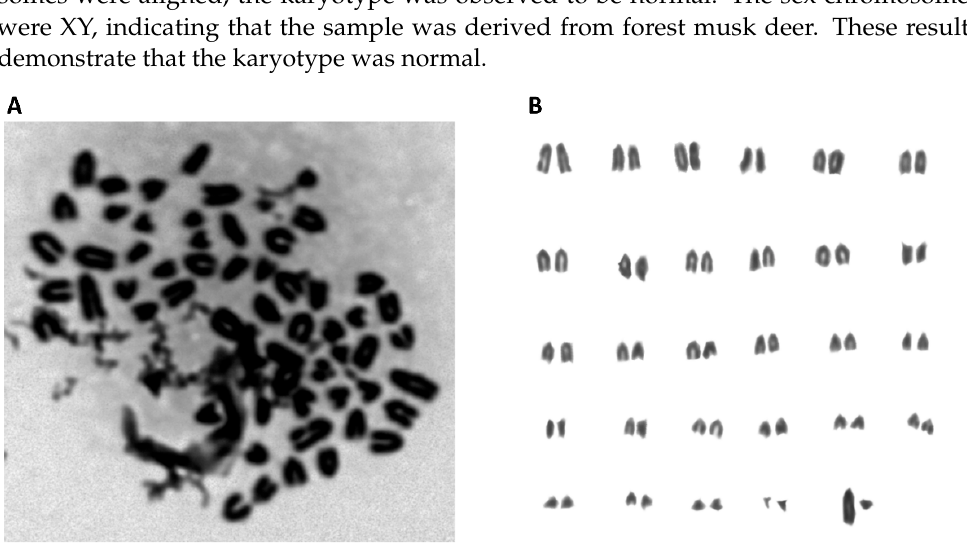
Figure 1. ( A ) Cell morphology of MSCs in vitro cultured at 3 passages. Cells exhibited spindle and fusiform shapes. Scale bar: 100 µm; ( B ) Unigenes length distribution after transcriptome sequencing and de novo assemble. The x-axis represents the length of unigenes, and the y-axis represents the number of unigenes within a certain length range.